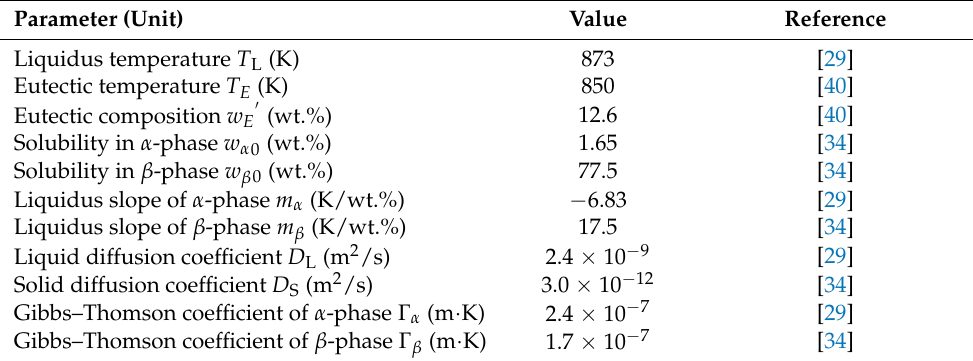
Table 1. Material properties and simulation parameters of AlSi10Mg alloy. Parameter (Unit) Value